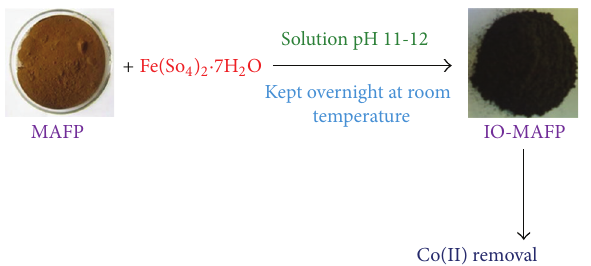
Figure 1: Schematic representation of preparation of iron oxide impregnated Morus alb L. fruit peel powder (IO-MAFP)